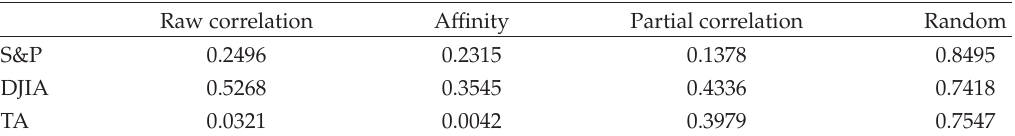
Table 4: Spectral Entropy for the three di ff erent datasets, for each of the four similarity cases. For the raw correlation and a ffi nity, the first eigenvalue was removed. Raw correlation A ffi nity Partial correlation